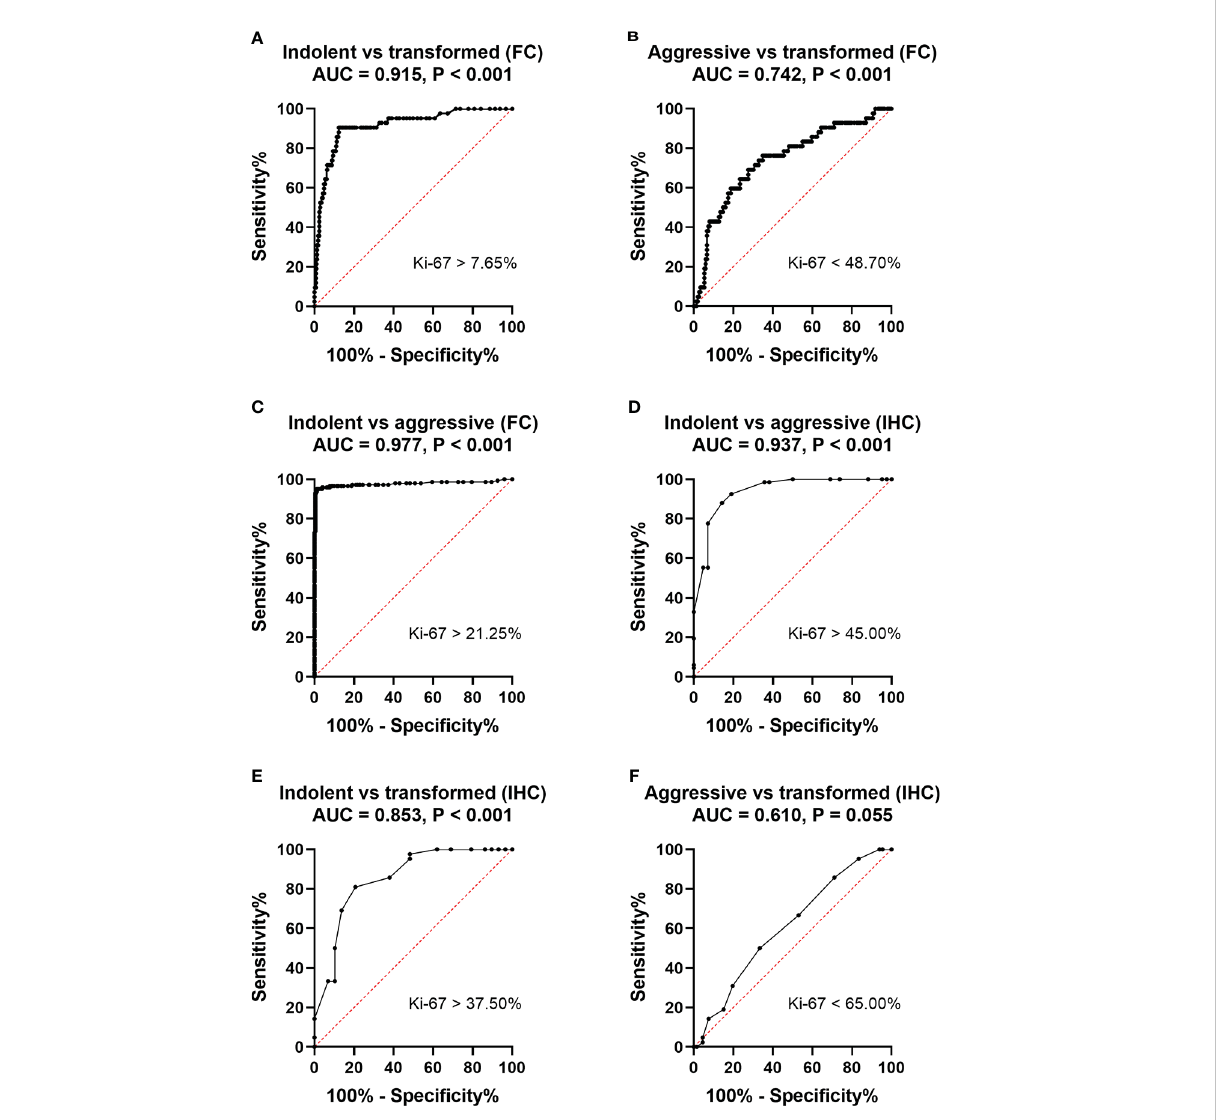
FIGURE 4 ROC curves for the sensitivity and speci fi city of the positive rate of Ki67 expression in the diagnosis of non-Hodgkin B-cell lymphoma. A comparison between indolent and aggressive large B lymphomas and transformed B cell lymphoma. (A) ROC analysis of the positive rate of Ki67 expression by MFC. Indolent- vs transformed B cell- lymphomas. AUC, 0.915. (B) ROC analysis of the positive rate of Ki67 expression by MFC. Aggressive large B cell-vs transformed B cell- lymphomas. AUC, 0.742. (C) ROC analysis of the positive rate of Ki67 expression by MFC. Indolent- vs aggressive large B- lymphomas. AUC, 0.977. (D) . ROC analysis of the positive rate of Ki67 expression by pathological IHC. Indolent- vs aggressive large B- lymphomas. AUC, 0.937. (E) . ROC analysis of the positive rate of Ki67 expression by pathological IHC. Indolent- vs transformed B-cell lymphomas. AUC, 0.853. (F) ROC analysis of the positive rate of Ki67 expression by pathological IHC. Aggressive- vs transformed B-cell lymphomas. AUC,